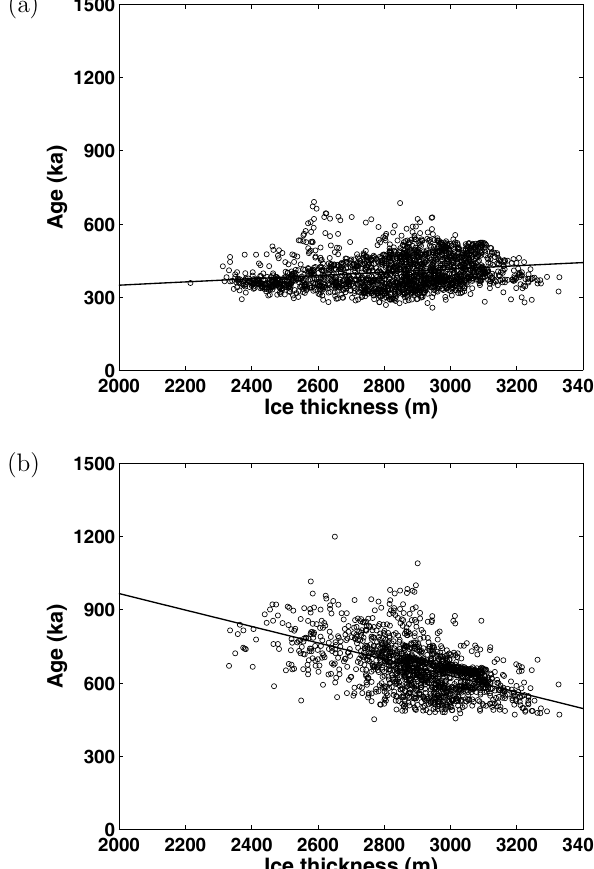
Figure 2: Isotropic steady-state run: (a) Age at 95% depth vs. ice thickness for all nodes Fig. 16. Isotropic steady-state run: (a) age at 95% depth vs. ice of the finite-element mesh; linear regression line. (b) Basal age vs. ice thickness for all thickness for all nodes of the finite element mesh; linear regression nodes of the finite-element mesh where the basal temperature is at the pressure melting line. (b) Basal age vs. ice thickness for all nodes of the finite ele- point; linear regression line. ment mesh where the basal temperature is at the pressure melting point; linear regression